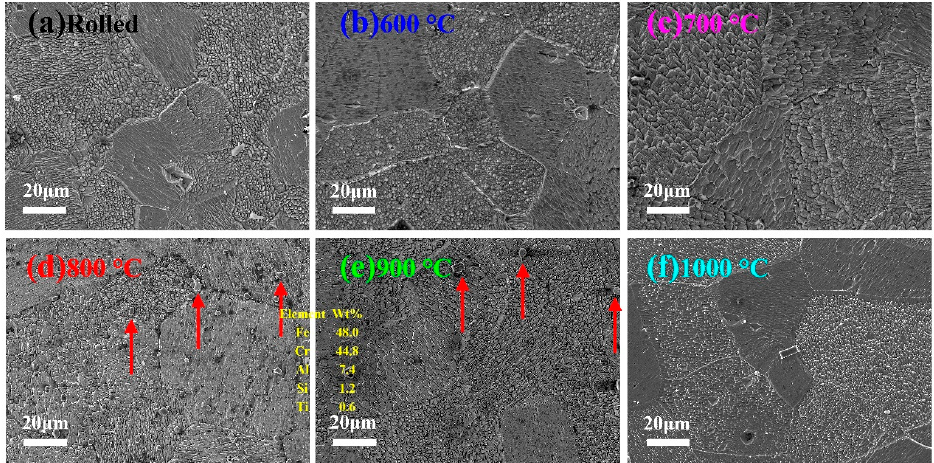
Figure 4. Typical SEM images (low magnification) showing α phase morphology and precipitates in the rolled and heat-treated Fe-25Cr-5Al-RE wire rod. ( a ): rolled; ( b ): 600 °C; ( c ): 700 °C; ( d ): 800 °C; ( e ): 900 °C; ( f ): 1000 °C.